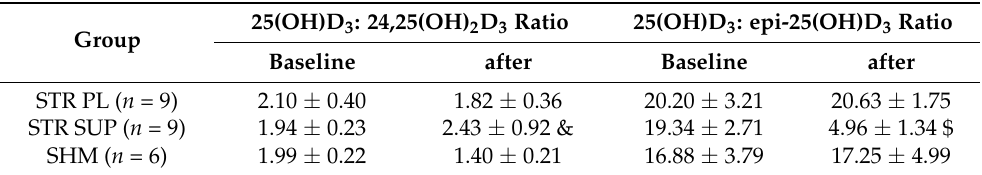
Table 2. The 25(OH)D 3 and its metabolite ratios at baseline and the end of the experiment in stressed rats.